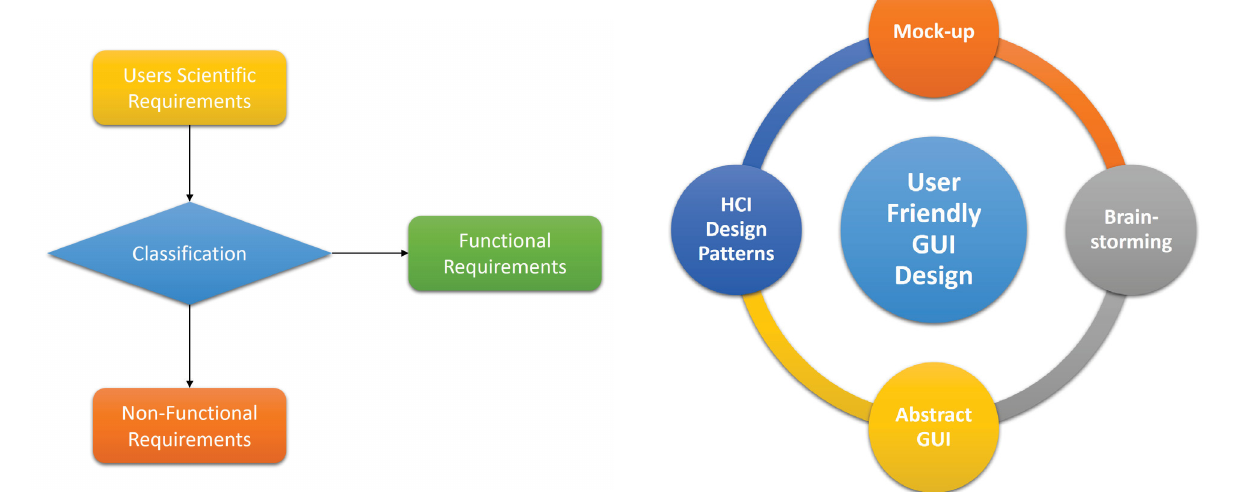
Figure 6. Requirements engineering and analysis. This is the 2 nd step of the top layer (gray layer) of the three layer model in the Butterfly design. Key tasks are indicated.